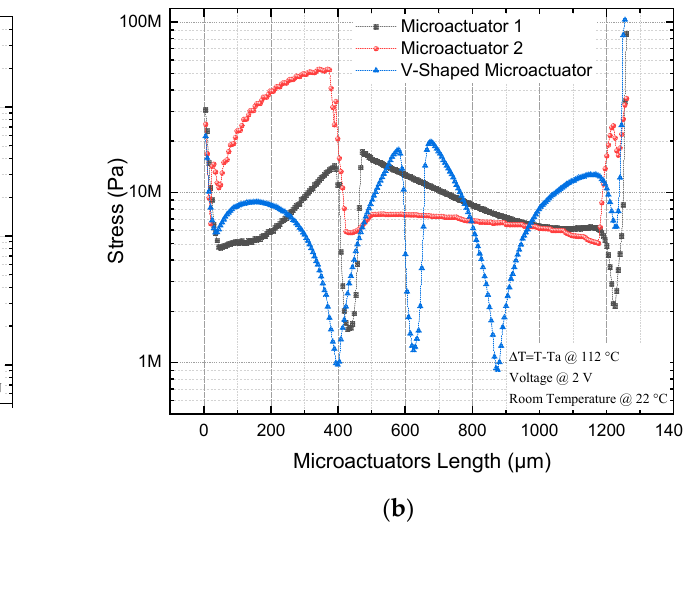
Figure 7. ( a ) Temperature and ( b ) displacement of microactuators 1, 2, and V-shaped.